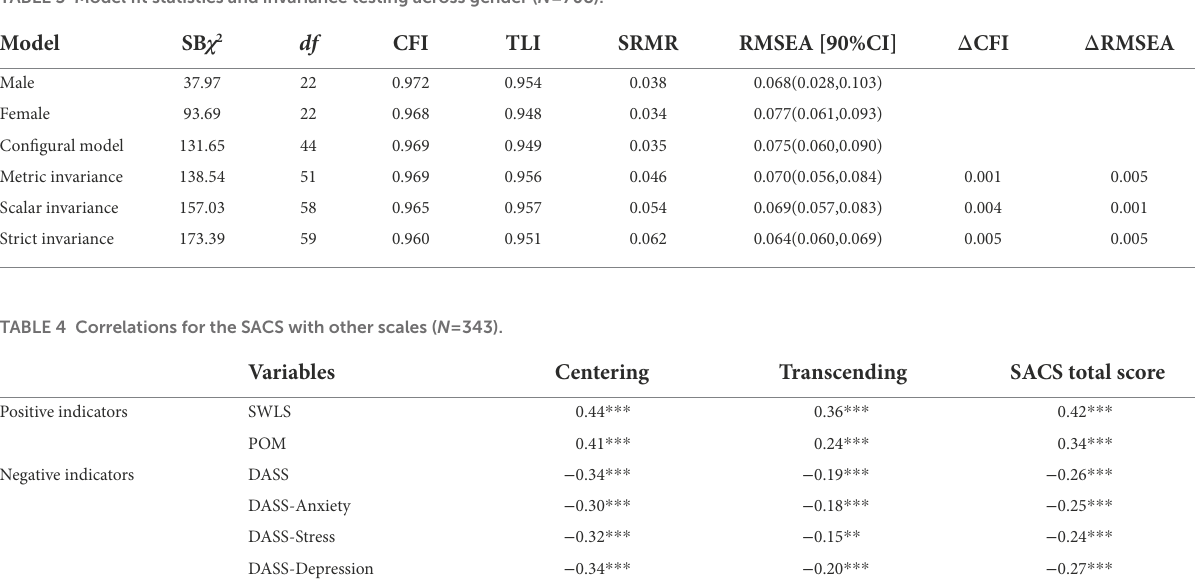
TABLE 3 Model fit statistics and invariance testing across gender ( N = 708).